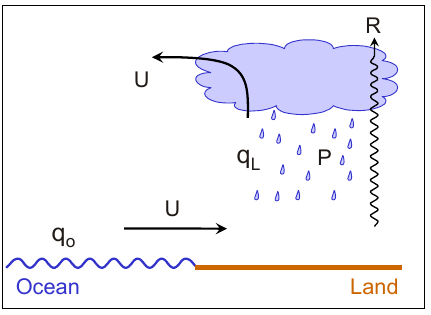
Fig. 1. Geometry of the conceptual model, illustrating wind U , pre- cipitation P , net radiative flux R , and atmospheric specific humidity over land ( q L ) and ocean ( q o ).